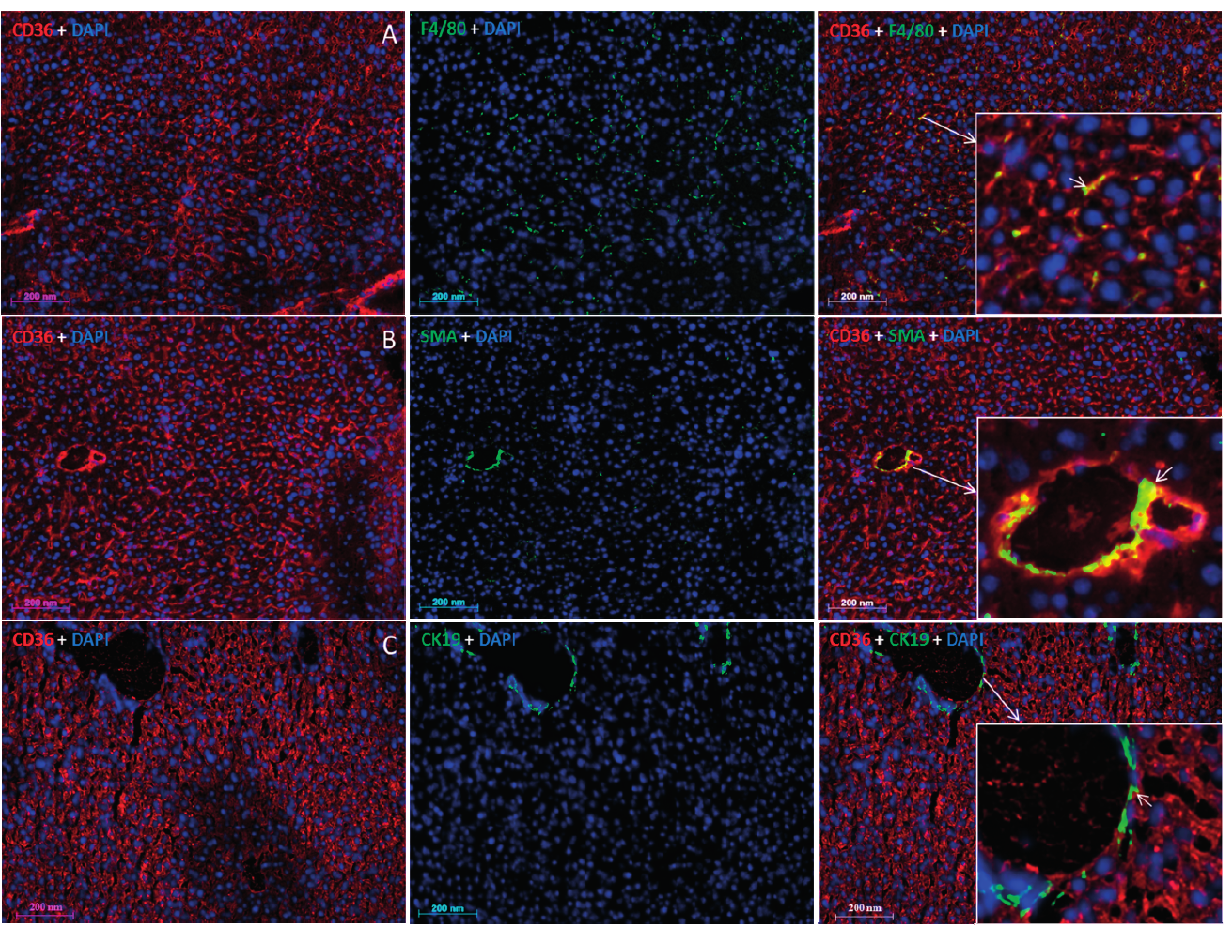
Figure 5. Immunofluorescence double-staining of mice liver cryosections. Row A : Monoclonal antibody against FAT/CD36 ( A left , red), monoclonal antibody directed against F4/80 ( A middle , green) and merged FAT/CD36 and F4/80 ( A right ); Row B : Monoclonal antibody against FAT/CD36 ( B left , red), monoclonal antibody directed against SMA ( B middle , green) and merged FAT/CD36 and SMA ( B right ); Row C : Monoclonal anti-FAT/CD36 antibody ( C left , red), polyclonal antibody directed against CK19 ( C , middle , green) and merged FAT/CD36 and CK19 ( C right ). Nuclei staining was done with (DAPI). The insets show higher magnification. Results show the representative picture of three animals and six slides (original magnification,